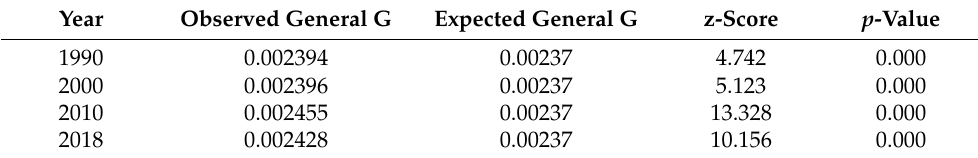
Table 5. Related parameters of the General G